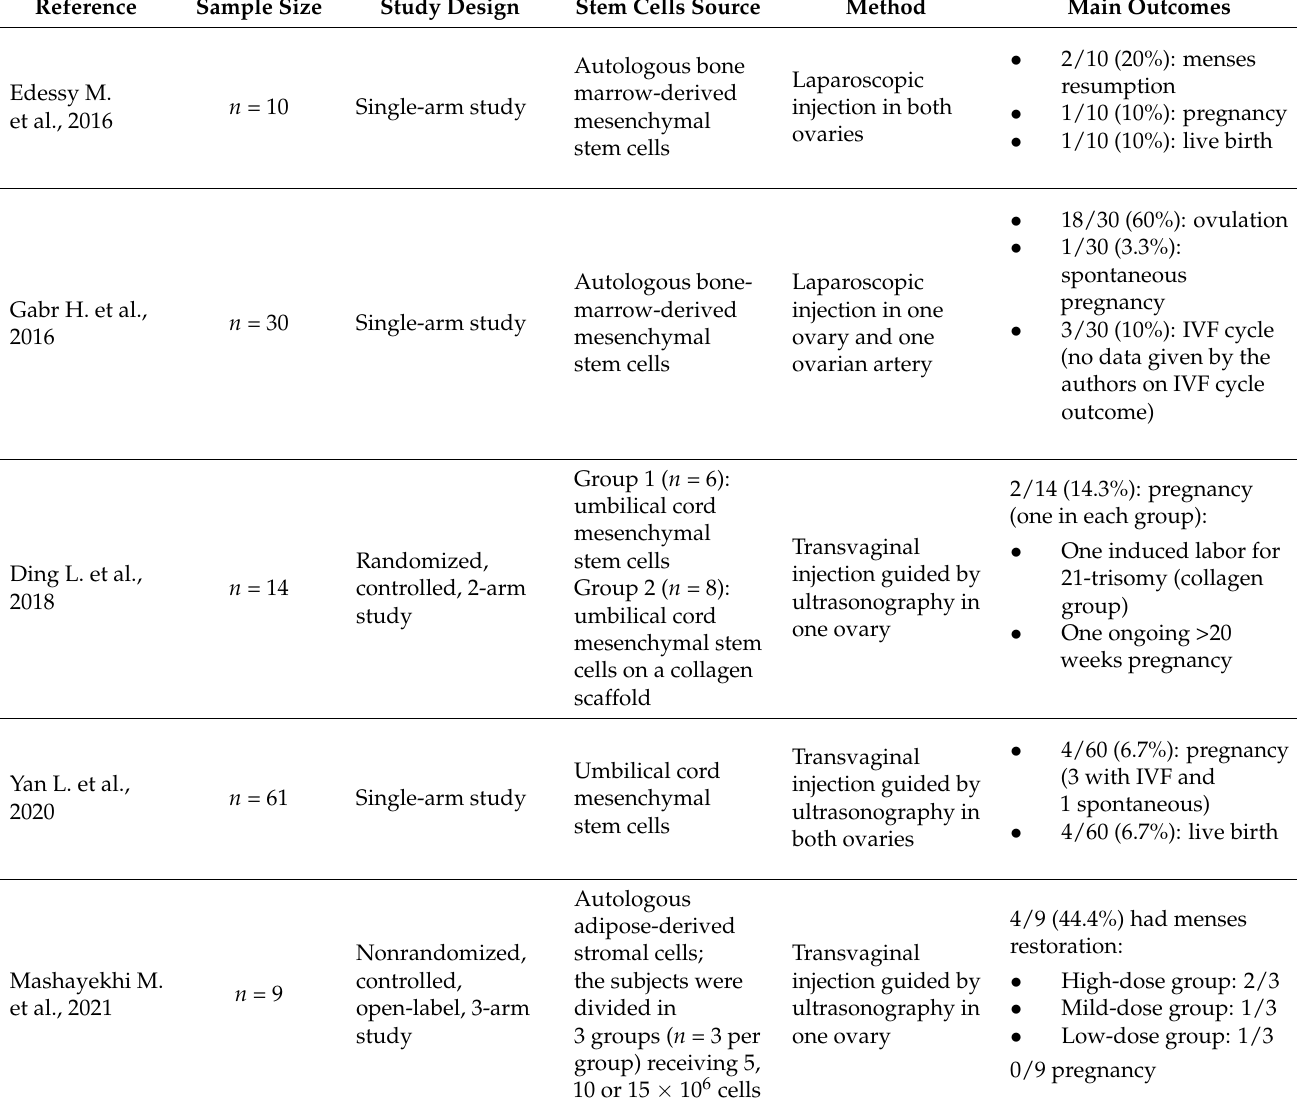
Table 2. Clinical studies conducted with stem cells to restore fertility in women suffering from spontaneous premature ovarian